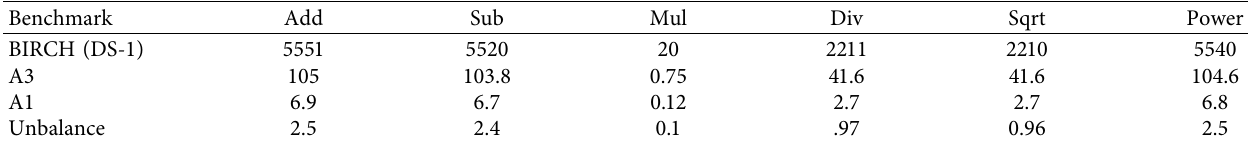
Table 2: (Number of arithmetic operations × 10 6 ) per each iteration.